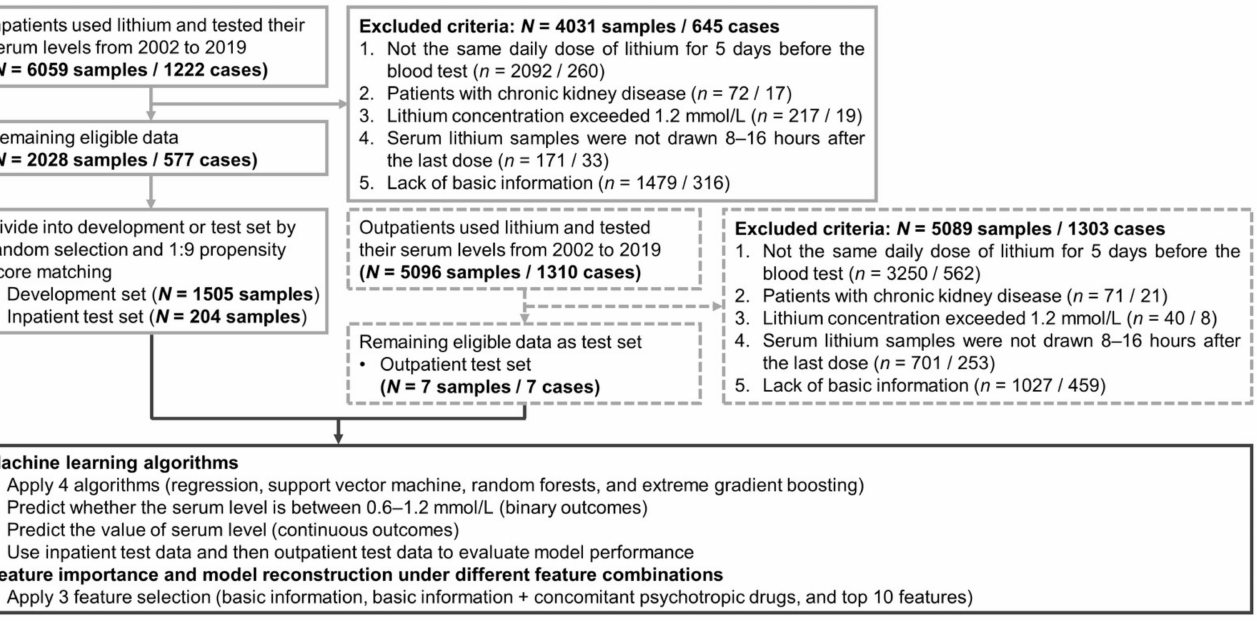
Figure 1. Flowchart of the selection process for this study and outline of analytic